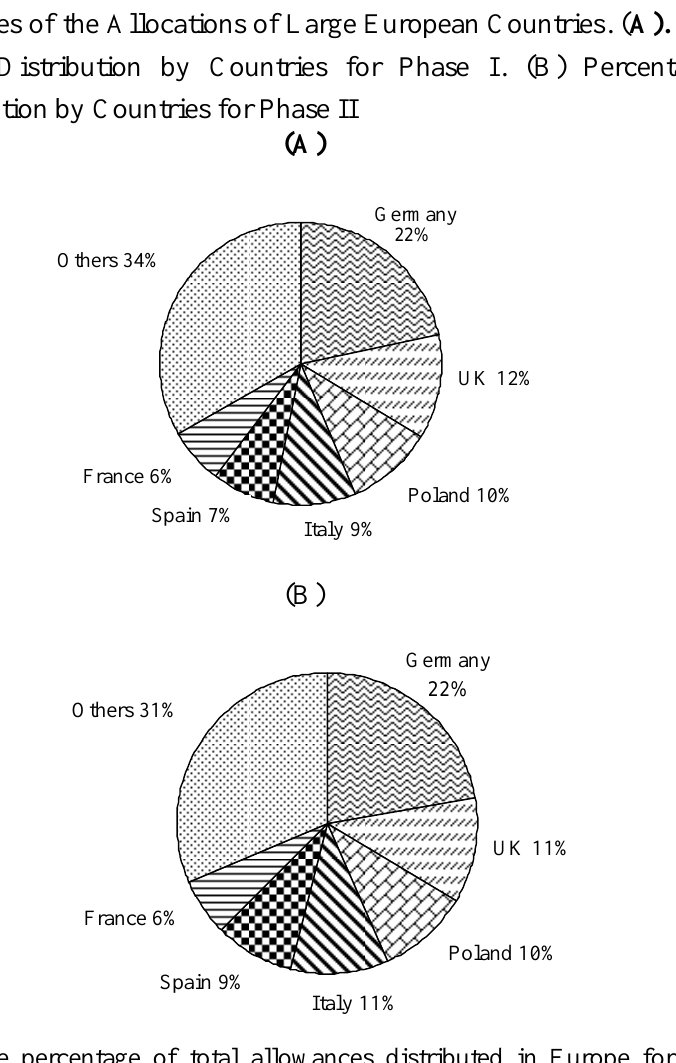
In Figure 3-A (B) the percentage of total allowances distributed in Europe for Phase I (II) is presented. Only the countries representing more than 5% of total emissions are considered. The countries that represent less than 5% are grouped in Others. Source: European